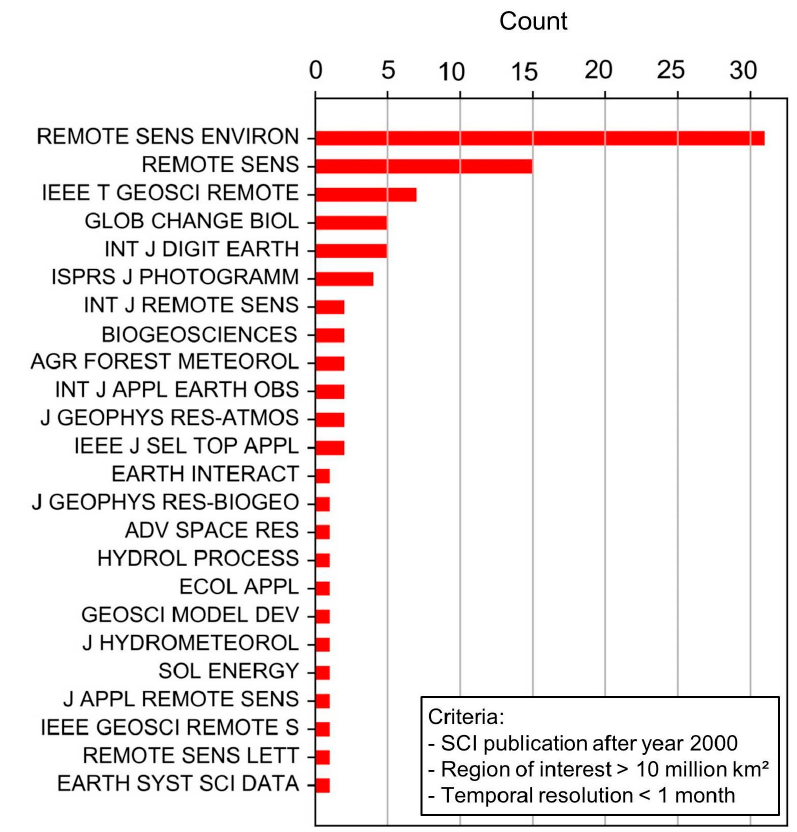
Figure 2. Journal histogram according to the paper selection in this review. Full journal names can be found in Table A1.